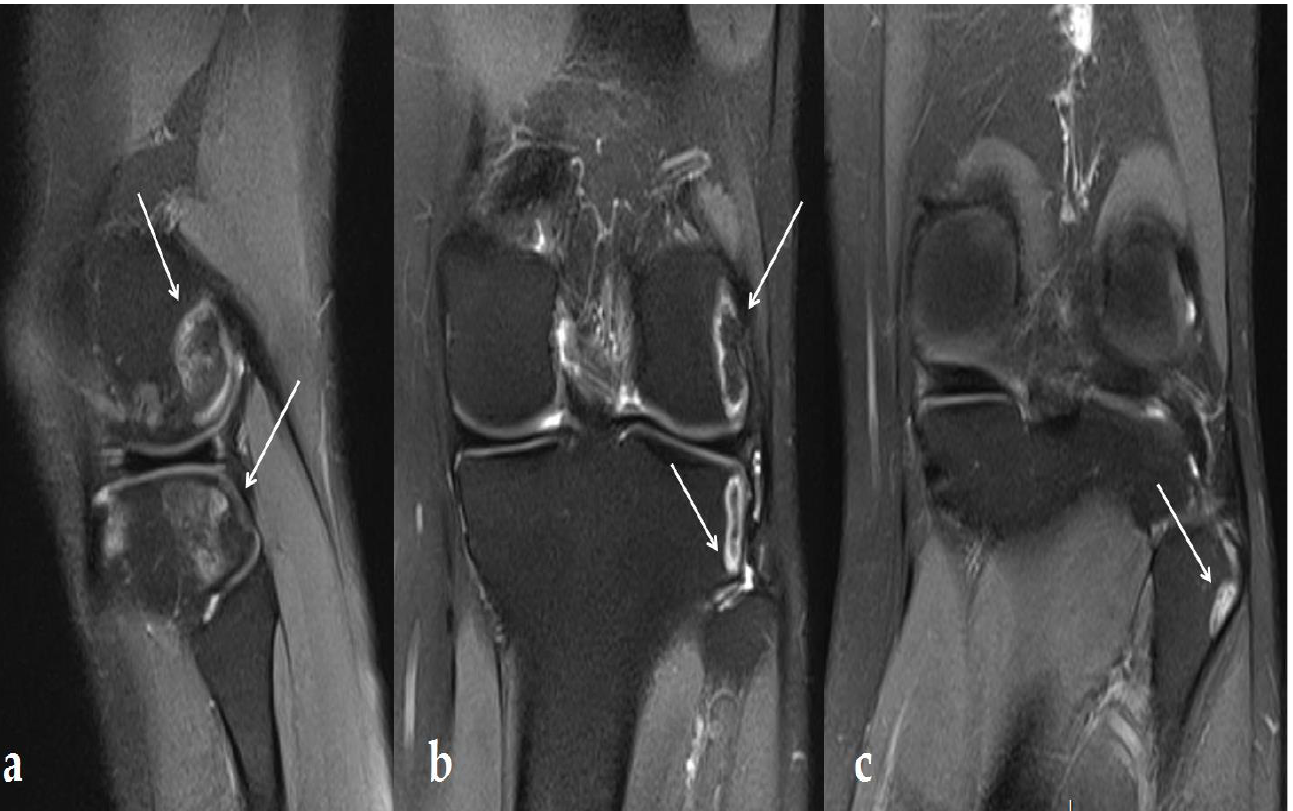
Figure 2. MRI: 1 month after the last US therapy. DP FS MRI image in sagittal ( a ) and frontal ( b,c ) sections demonstrating signal abnormalities under the epiphyseal cortex with hyper-intensity in the peripheral border: 21 × 20 × 12 mm lesion on the femur, 16x18x15 mm on the tibia, and 10 × 9 × 9 mm on the proximal fibula, highlighted with white arrows.